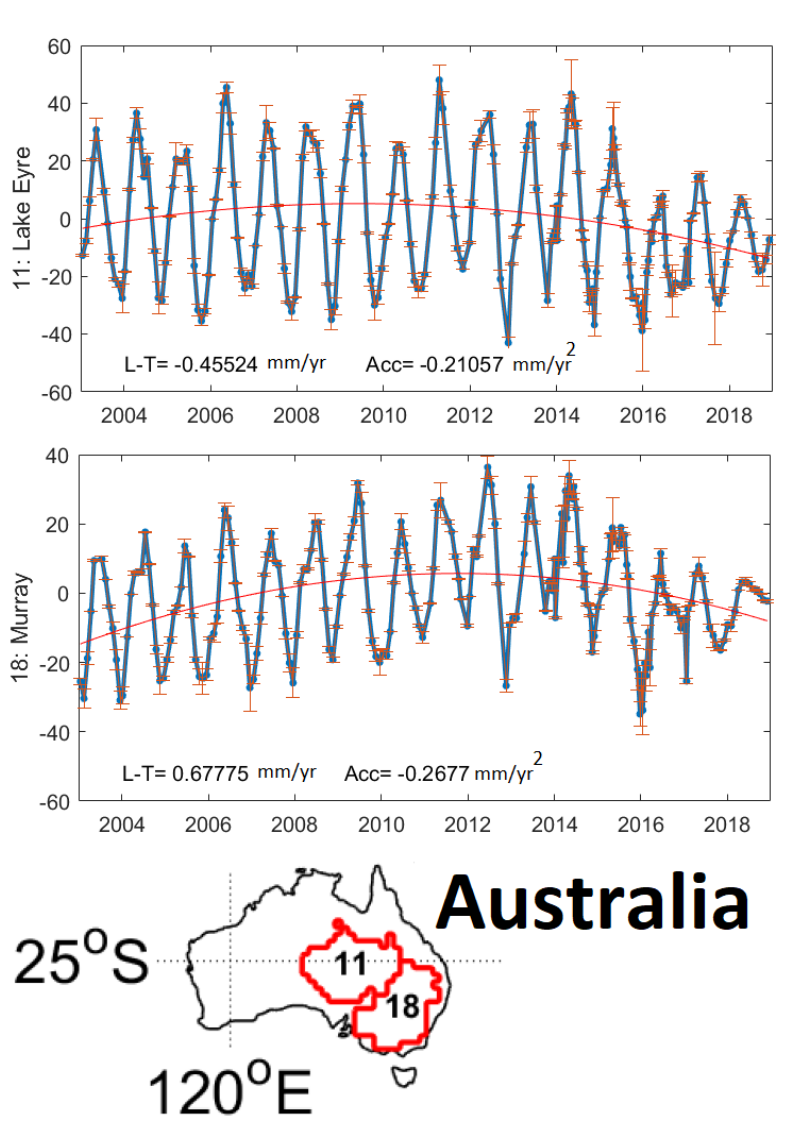
Figure 13. Basin average of the reconstructed TWSC fields within the two major river basins within the Australian continent covering 2003–2018. The red lines show the long-term linear trend (L-T (mm/yr)) and acceleration (Acc (mm/yr 2 )) components fitted to the TWSC